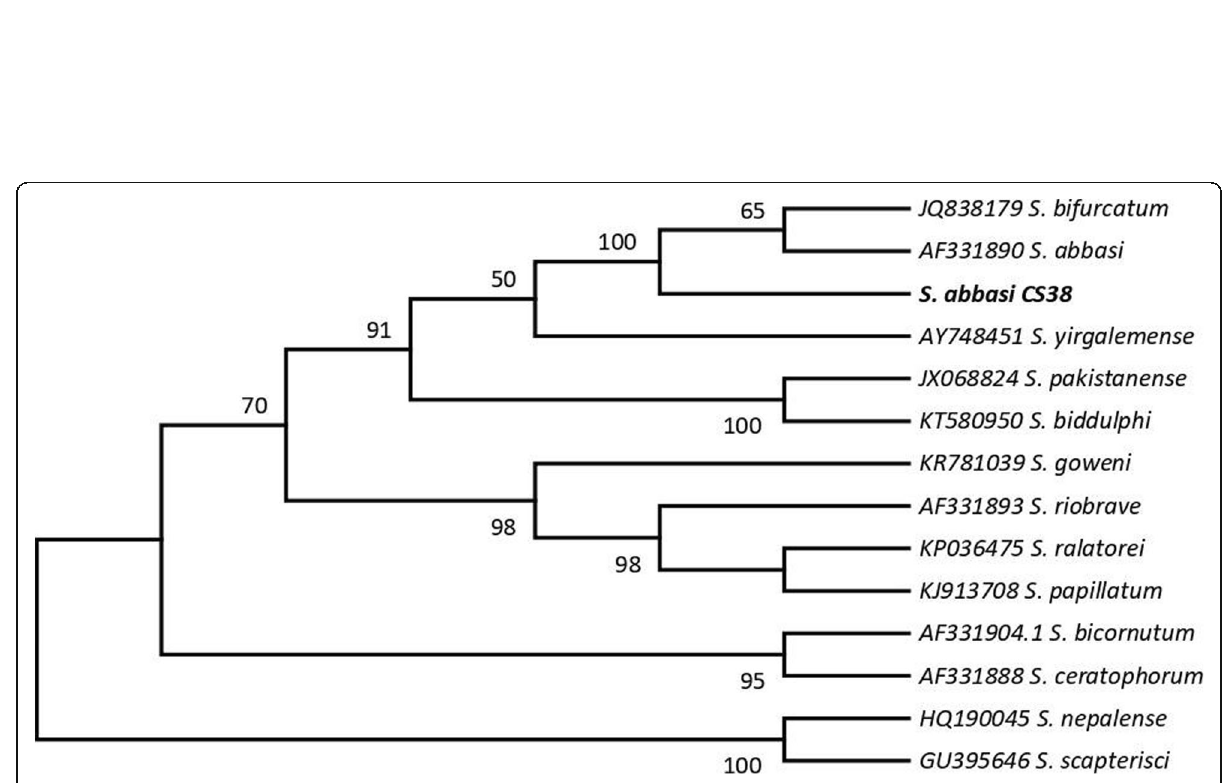
Fig. 3 Phylogenetic relationships in the “ bicornatum ” group of Steinernema based on analysis of D2D3 regions. Steinernema scapterisci and Steinernema nepalense were used as outgroup taxa. The percentage of replicate trees in which the associated taxa clustered together in the bootstrap test (10,000 replicates) is shown next to the branches. Branch lengths indicate evolutionary distances and are expressed in the units of number of base differences per